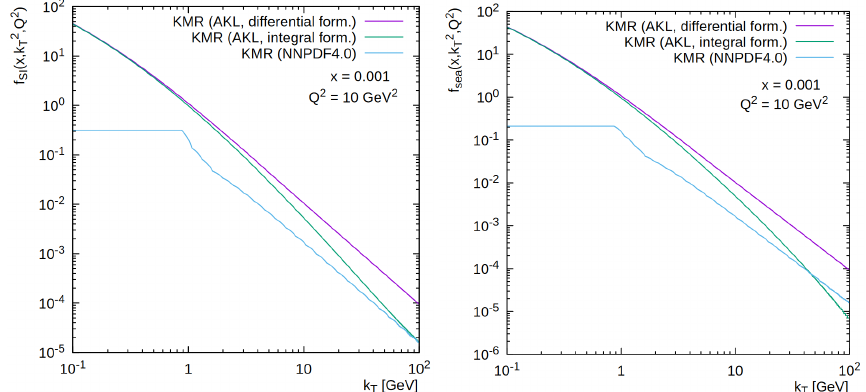
Figure 2. The TMD gluon, valence, singlet and sea quarks densities in the proton calculated as a function of the parton transverse momentum k 2 at longitudinal momentum fraction x = 0.001 and T hard scale Q 2 = 10 GeV 2 . The purple and green curves correspond to the results obtained with AKL sets, which were obtained from differential and integral formulations of KMR approach, respectively. The blue curve corresponds to the results obtained with TMD gluon distribution JH’2013 set 2 and with TMD quark distributions calculated numerically in the traditional KMR scenario, where the conventional parton densities from standard NNPDF (LO) set are used as an